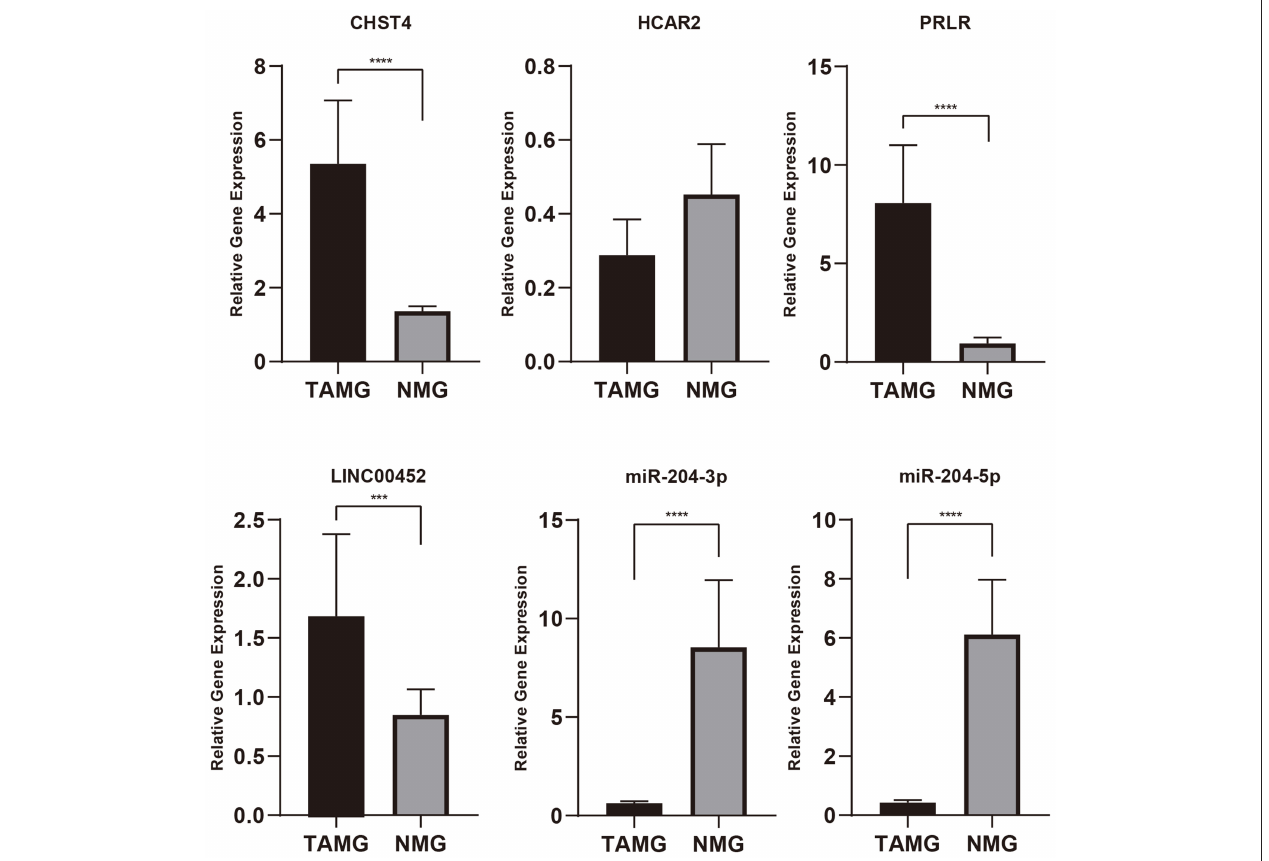
FIGURE 9 | The relative expression of genes of interest in thymic tissue by qPCR. As shown in this figure, CHST4, PRLR, and LINC00452 were highly expressed in patients with TAMG, and miR-204-3p and miR-204-5p were expressed at low levels in patients with TAMG. n.s., not significant; *** p < 0.001; **** p < 0.0001.